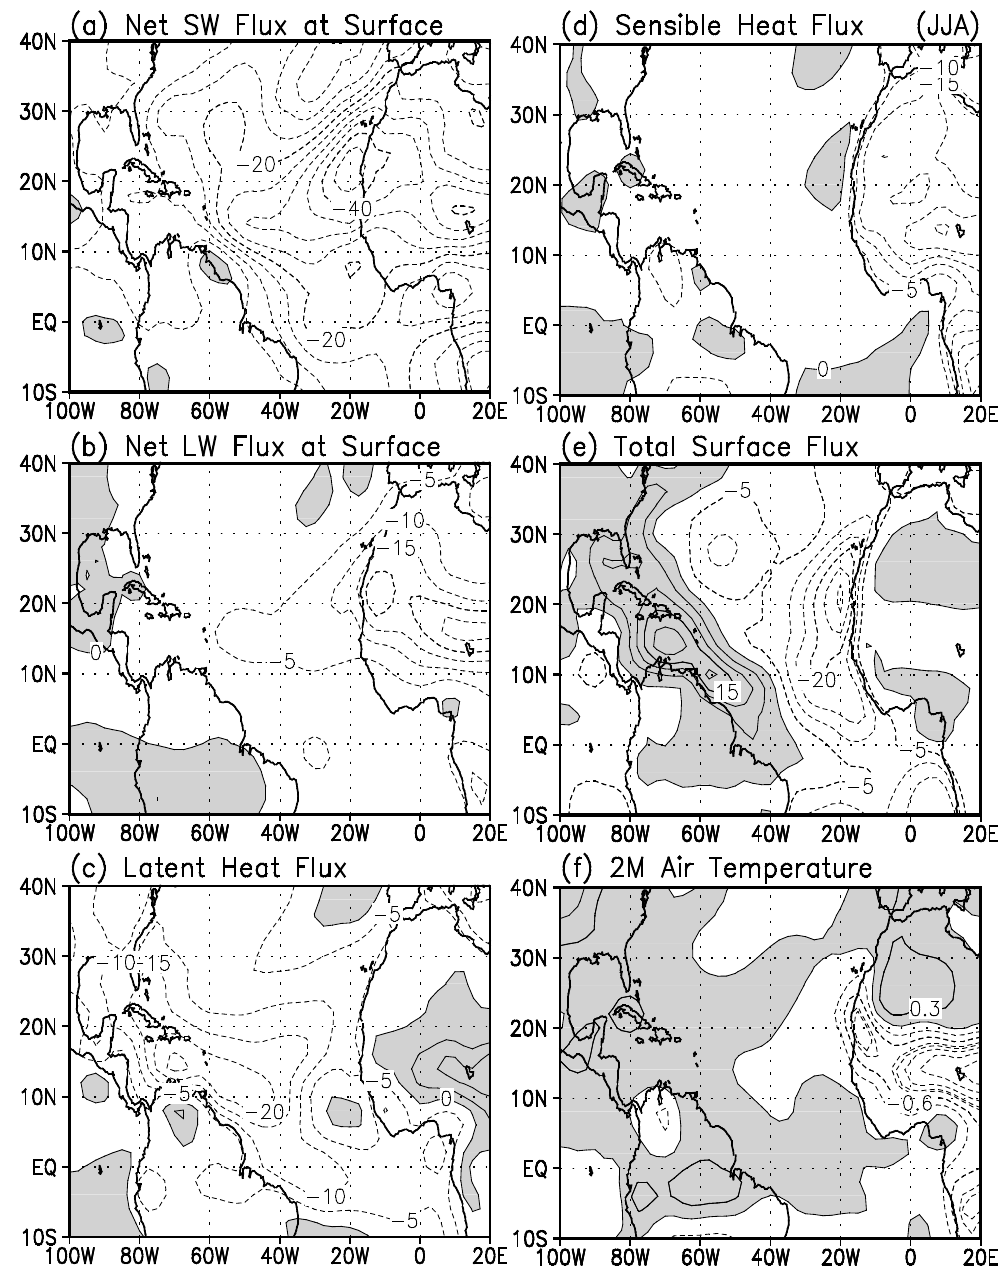
Fig. 4. JJA dust induced anomalies in (a) surface shortwave flux, (b) surface long wave flux, (c) surface latent heat flux, (d) surface sensible heat flux, (e) total surface heat flux, and (f) surface air temperature at 2m. All fluxes use upward-positive convention, except shortwave and total fluxes which are positive downward. Units are Wm − 2 for fluxes and ◦ C for temperature. Figure 4 JJA dust induced anomalies in a) surface shortwave flux b) surface long wave flux, c) over the WAM land region, is statistically significant, even surface latent heat flux, d) surface sensible heat flux, e) total surface heat flux, and though much weaker, because of the model’s dry bias f) surface air temperature at 2 meter.